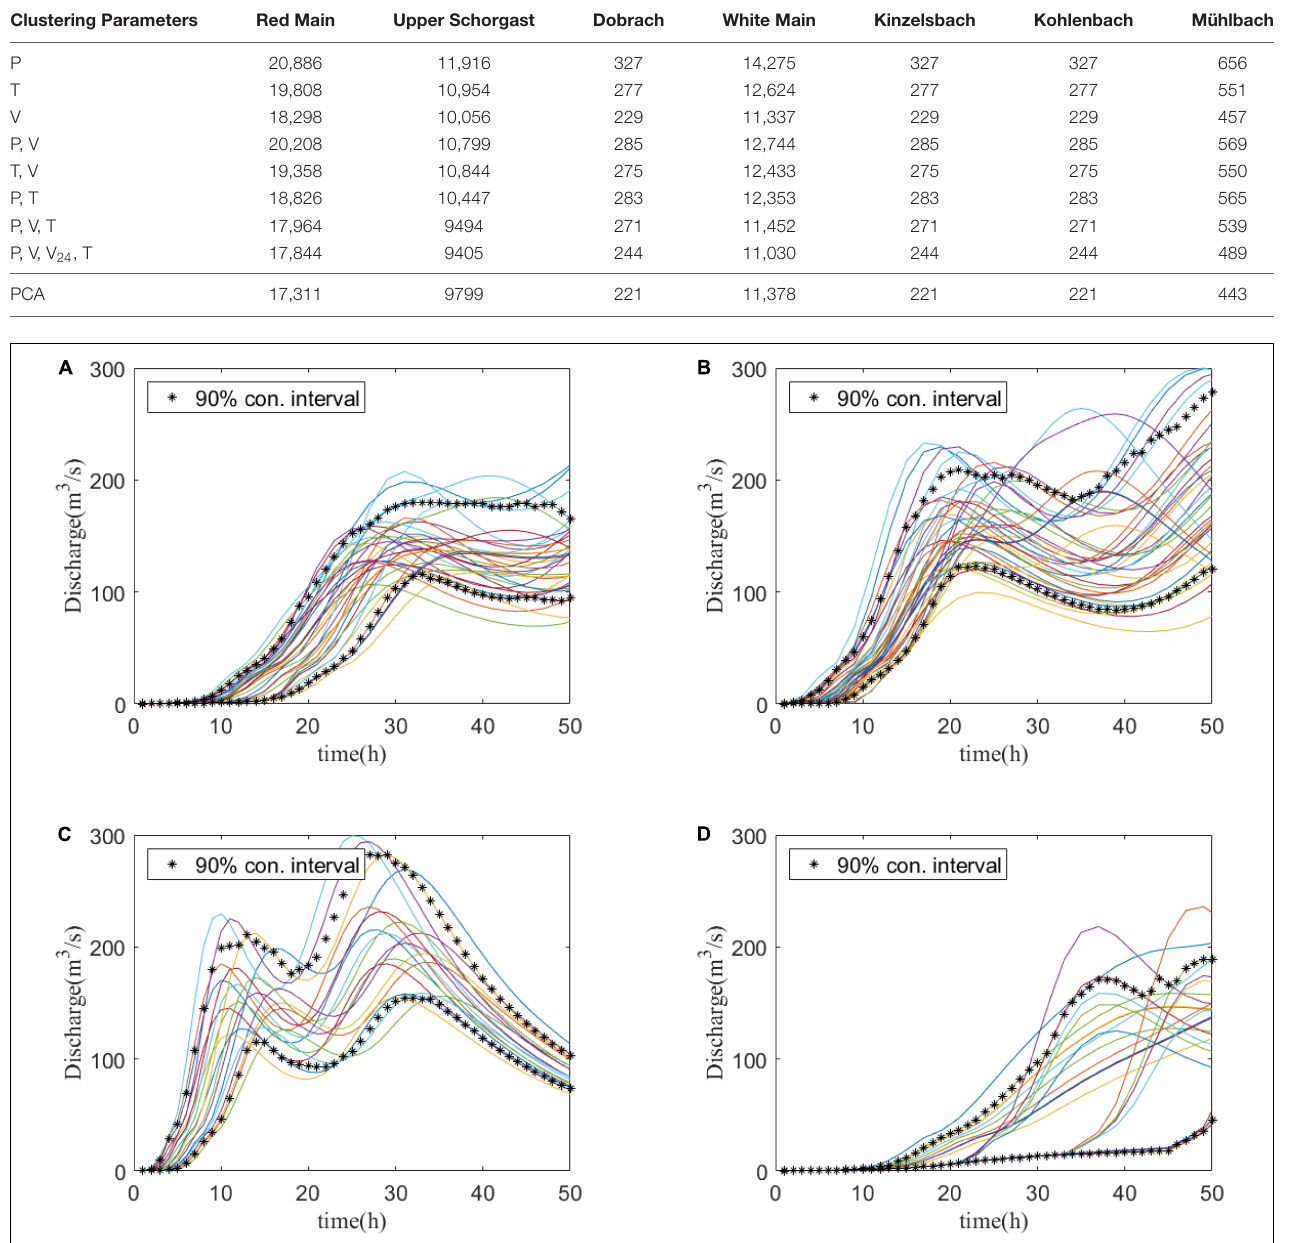
FIGURE 7 | Clustering of all the discharge curves in the training dataset of Stream Red Main (biggest inflow) grouped into four clusters by conventional FCM. Each curve represents a single event. (A–D) The curves are clustered into the above four clusters. The clustering is based on the combination of P (peak discharge value), T (peak time), V (total volume), and V24 (volume in the first 24 h). Asterisks represent the 90% confidence intervals of the four clusters (A–D)